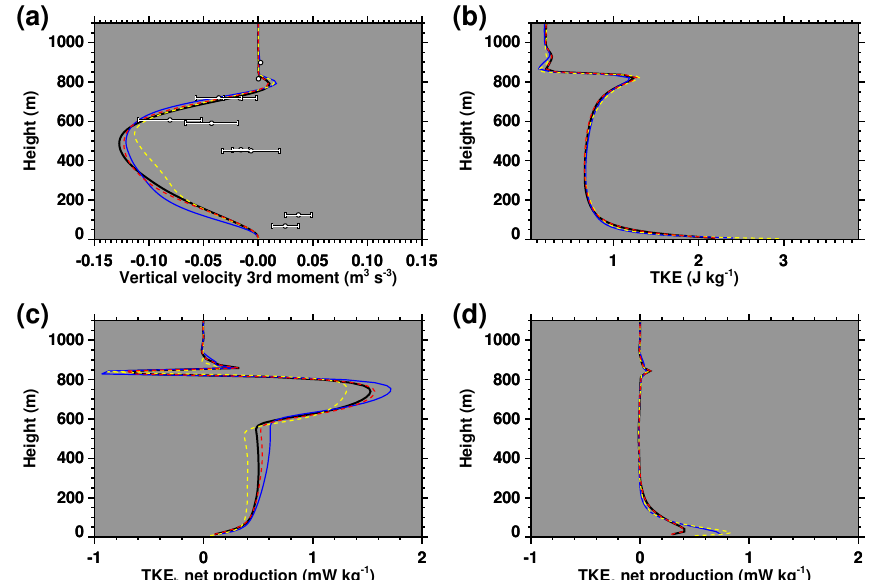
Figure 4. Final state of the spin-up runs (initial states of simulations). Mean final state of the spin-up run m (black), m fine (yellow), l (red), l 1 : 5 (blue). Markers indicate DYCOMS-II RF01 in situ (solid with bar) data (Stevens et al., 2005). Spin-up runs are listed in Table 1.